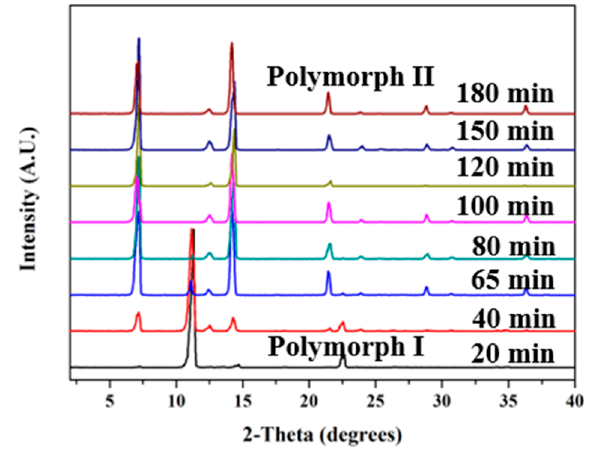
Figure 9. PXRD patterns of samples obtained in the polymorphic transformation of theophylline in methanol at 30 °C.